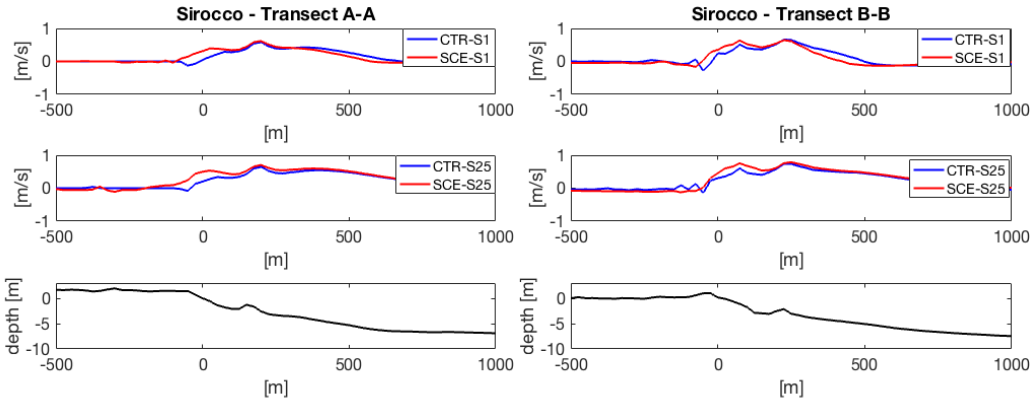
Figure 11. Sirocco events. Cross-shore distribution of the alongshore velocity as calculated by TEL2D for ordinary S1 and extreme S25 events and of the water depth along transect A-A ( left panels ) and transect B-B ( right panels ).